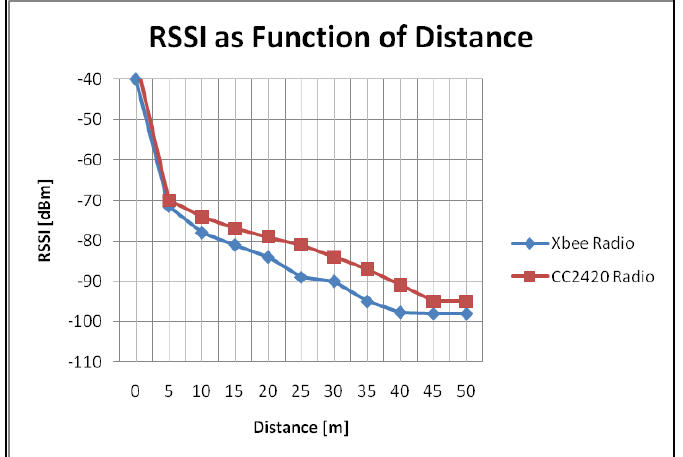
Figure 6. RSSI as function of distance.